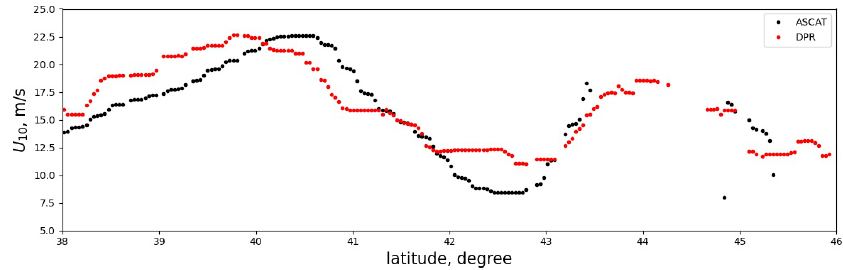
Figure 11. The section along the left edge of the DPR swath in Figure 10: ASCAT wind speed (black dots), DPR wind speed (red